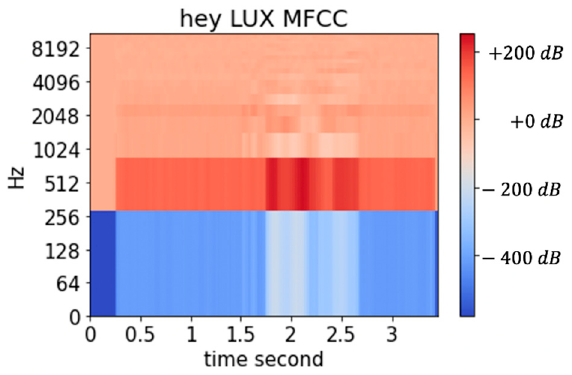
Figure 2. Example of “Hey LUX” MFCC.